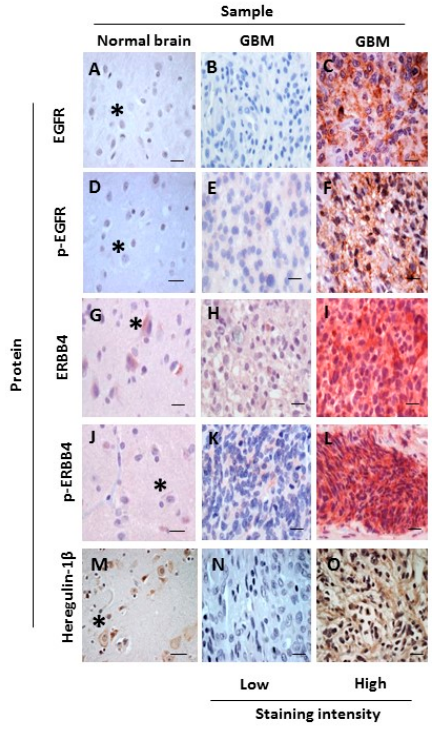
Figure 3. Representative IHC images of occipital regions in an NNB sample and a GBM sample. Samples were stained for EGFR ( A – C ), p-EGFR ( D – F ), ERBB4 ( G – I ), p-ERBB4 ( J – L ) and heregulin-1 β protein ( M – O ). Images are representative of high and low staining intensity of ERBB proteins (stained with VECTOR ® Red Alkaline Phosphatase (red), Burlingame, CA, USA) and of heregulin-1 β protein (stained with 3,3 ′ -Diaminobenzidine (DAB) (brown); nuclei were counterstained with hematoxylin (blue). Asterisks denote neurons. Scale bars, 25 µm.